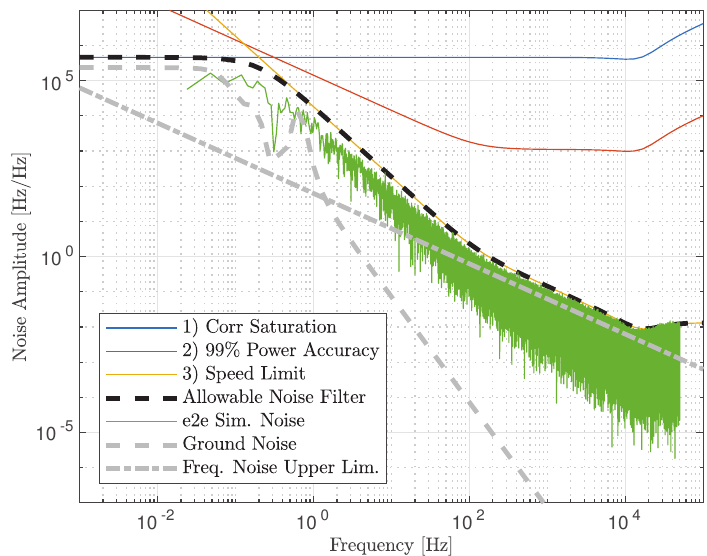
Figure 9. Maximum allowable noise filter defined as the minimum magnitude of anticipated constraining performance parameters. Also shown are the known ground and frequency noise levels.